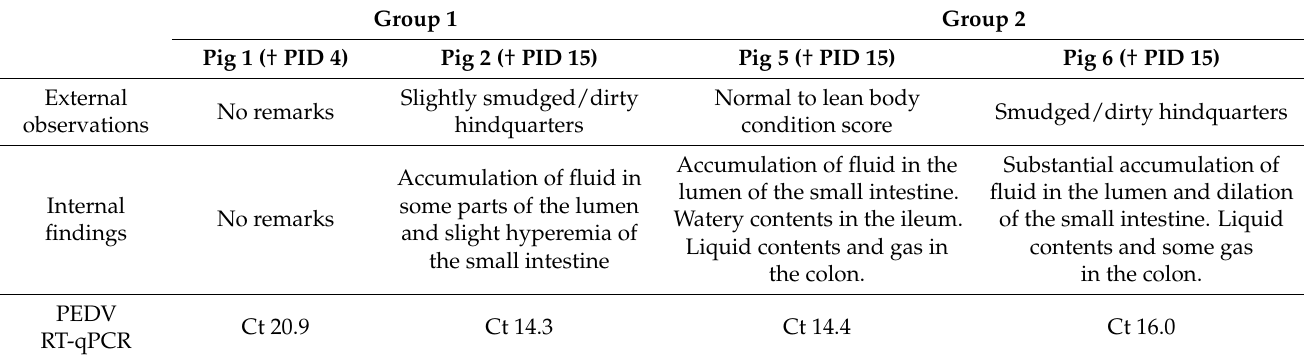
Table 2. Macroscopic findings during necropsy plus PEDV RNA detection within feces or intestinal